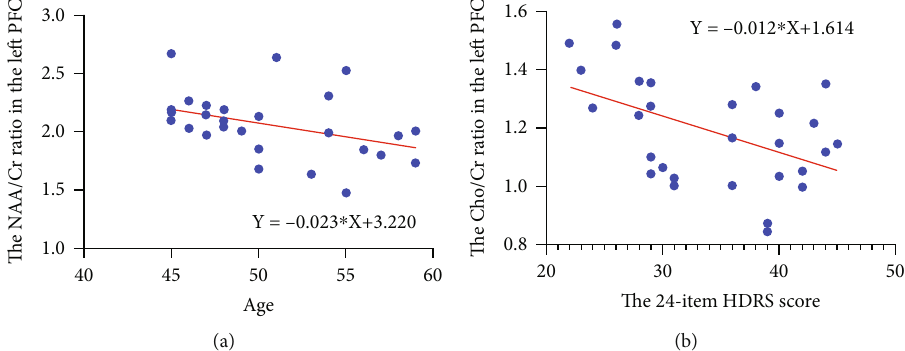
Figure 5: Correlations of biochemical metabolite ratios with clinical MDD data. (a) The correlation between left PFC NAA/Cr ratio and age. (b) The correlation between left PFC Cho/Cr ratio and 24-item HDRS